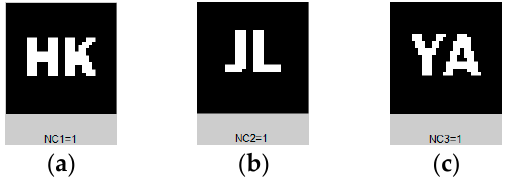
Figure 14. The extracted watermarks without attack: ( a ) extracted watermark 1; ( b ) extracted watermark 2; ( c ) extracted watermark 3.